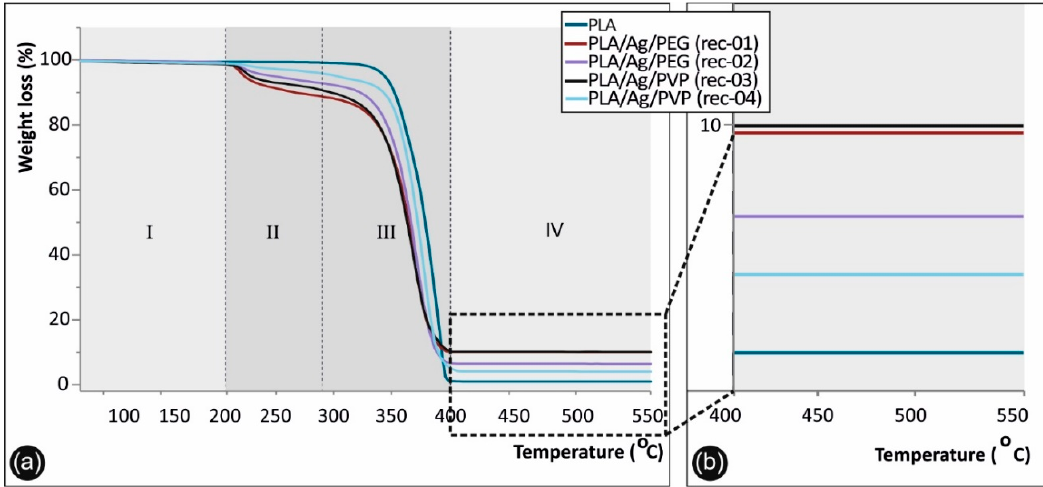
Figure 4. Thermogravimetric analysis (TGA) graphs of neat PLA, PLA/Ag/PEG, and